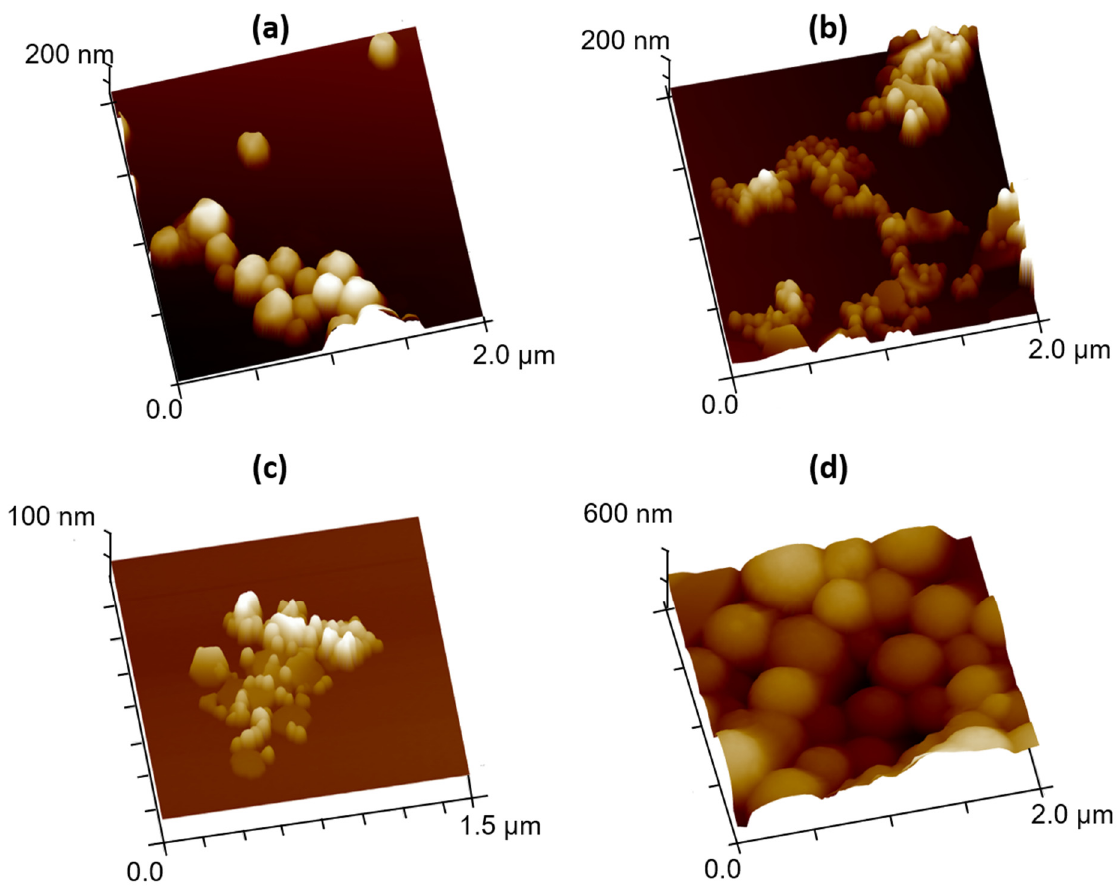
Figure 4. 3D AFM images of AuNPs. ( a ) Ratio 1; ( b ) Ratio 2; ( c ) Ratio 3; ( d ) Ratio 4. Considering the limited accuracy of the DLS analysis for more polydisperse samples, particle sizes were also analyzed by AFM, and the comparative results are shown in Figure 5. No significant differences were observed between the two methodologies except for the case of AuNPs from Ratio 4. In this case, smaller sizes by AFM than by DLS were observed.